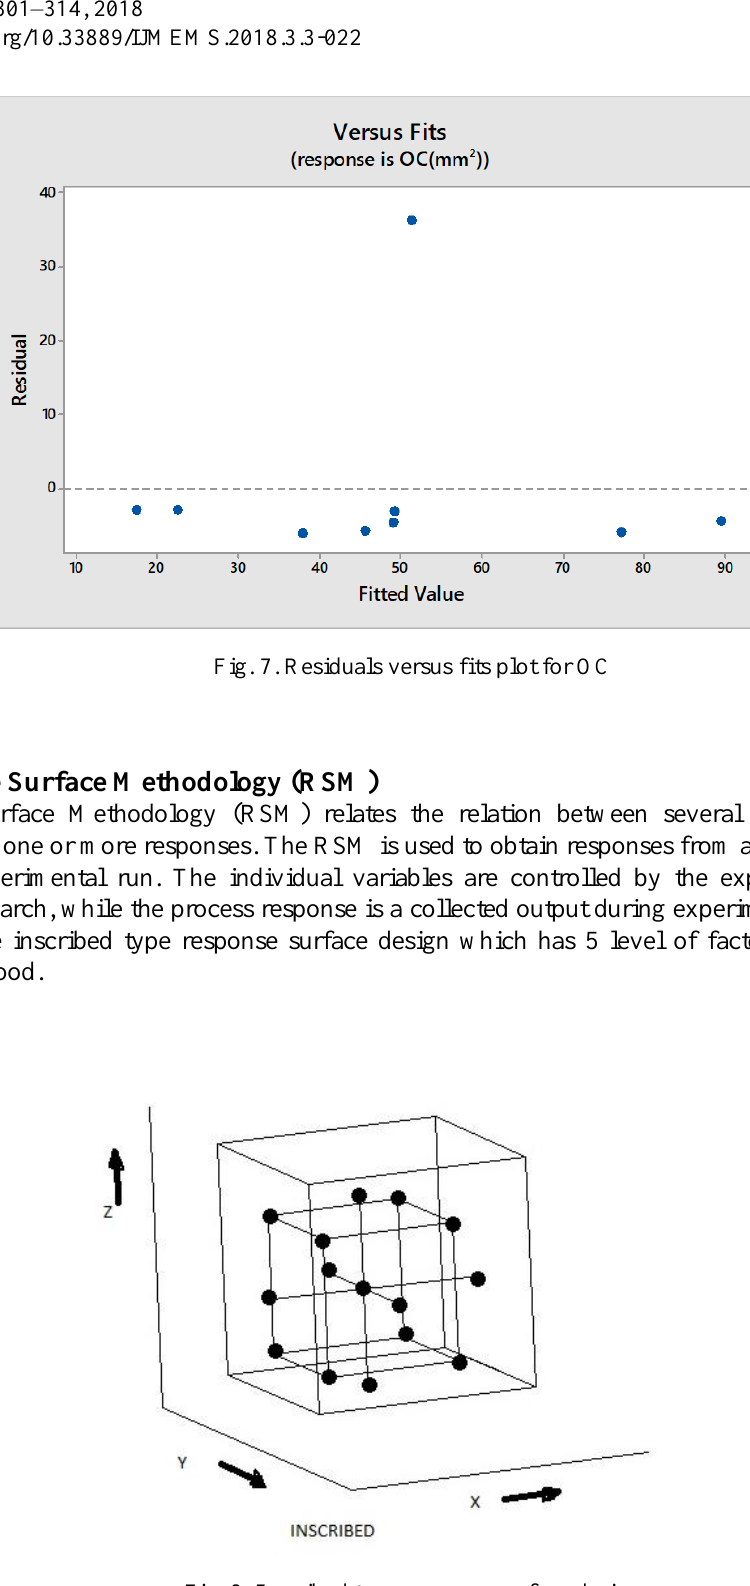
Fig. 8. Inscribed type response surface